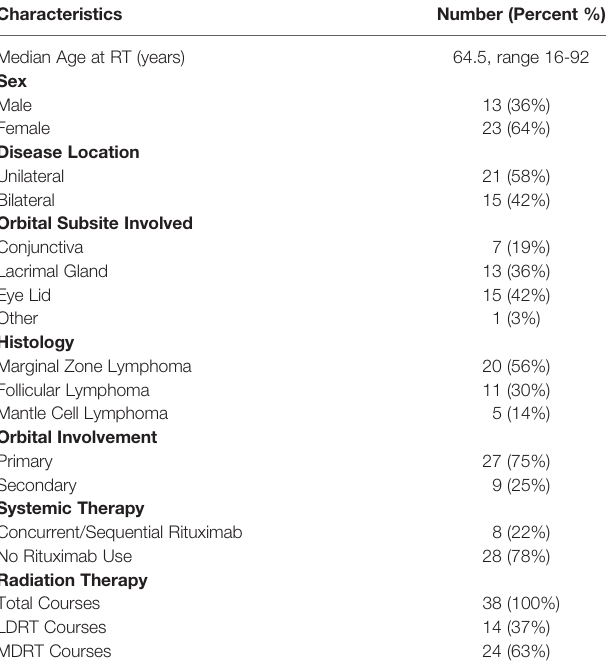
TABLE 1 | Baseline Patient Characteristics.